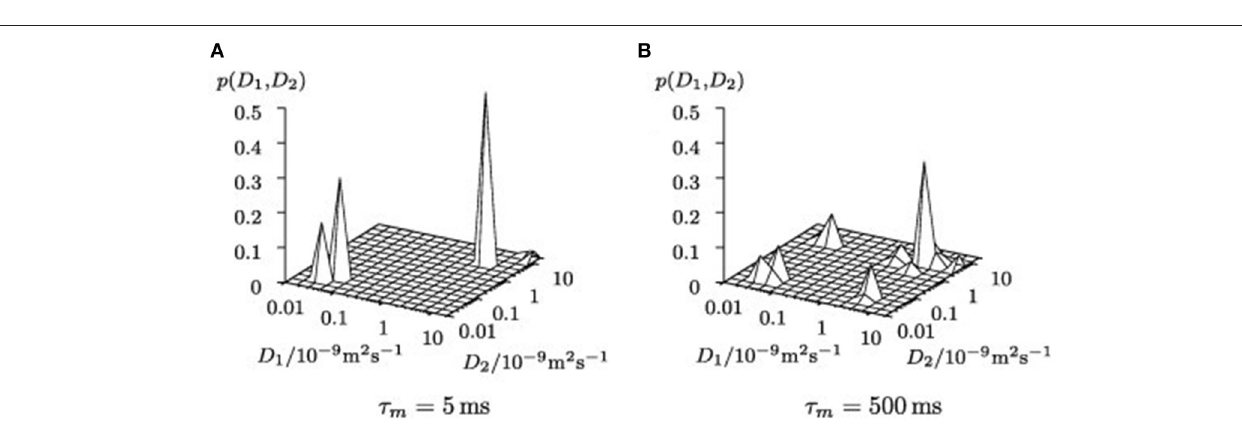
FIGURE 6 | Uncorrected 2D inverse Laplace transformed NMR signal maps of DEXSY experiments for different mixing times τ m (A) τ m = 5 ms, (B) τ m = 500 ms. Reprinted from Gratz et al. (2009), Copyright 2009 with permission from